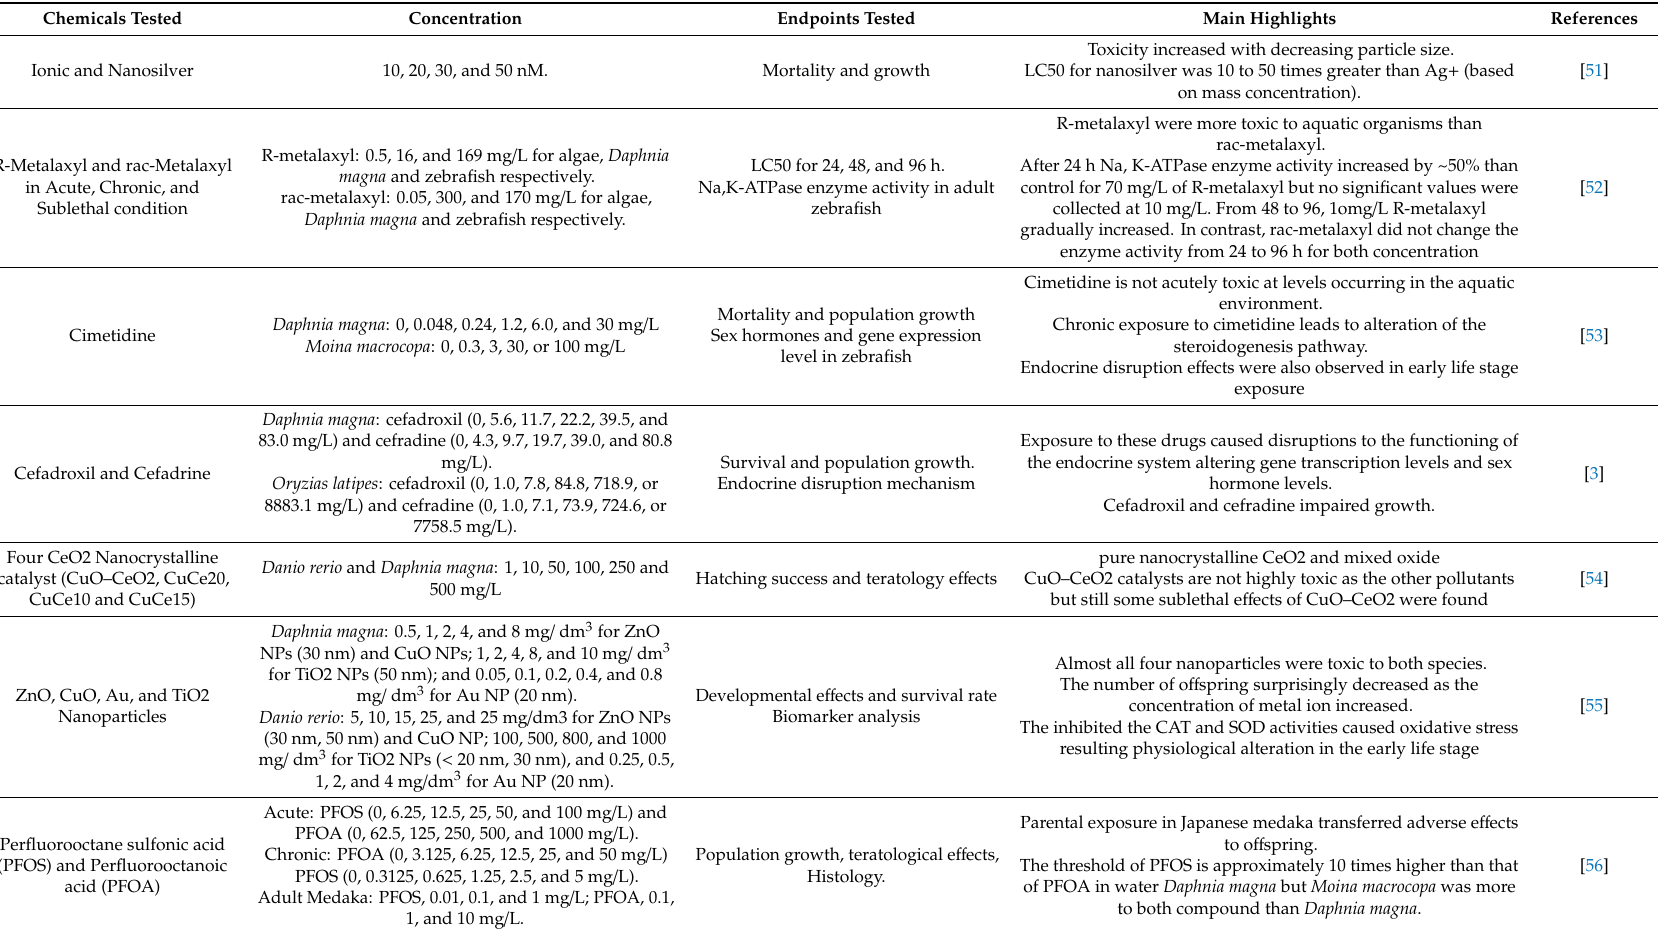
Table A1. Summary of papers that have used di ff erent model species for toxicity test dealing with di ff erent